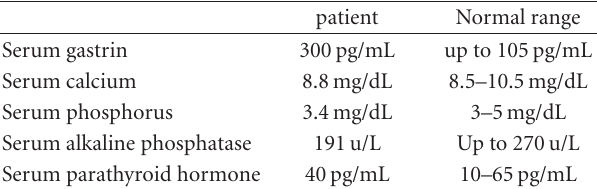
Table 1: Laboratory characteristics of the